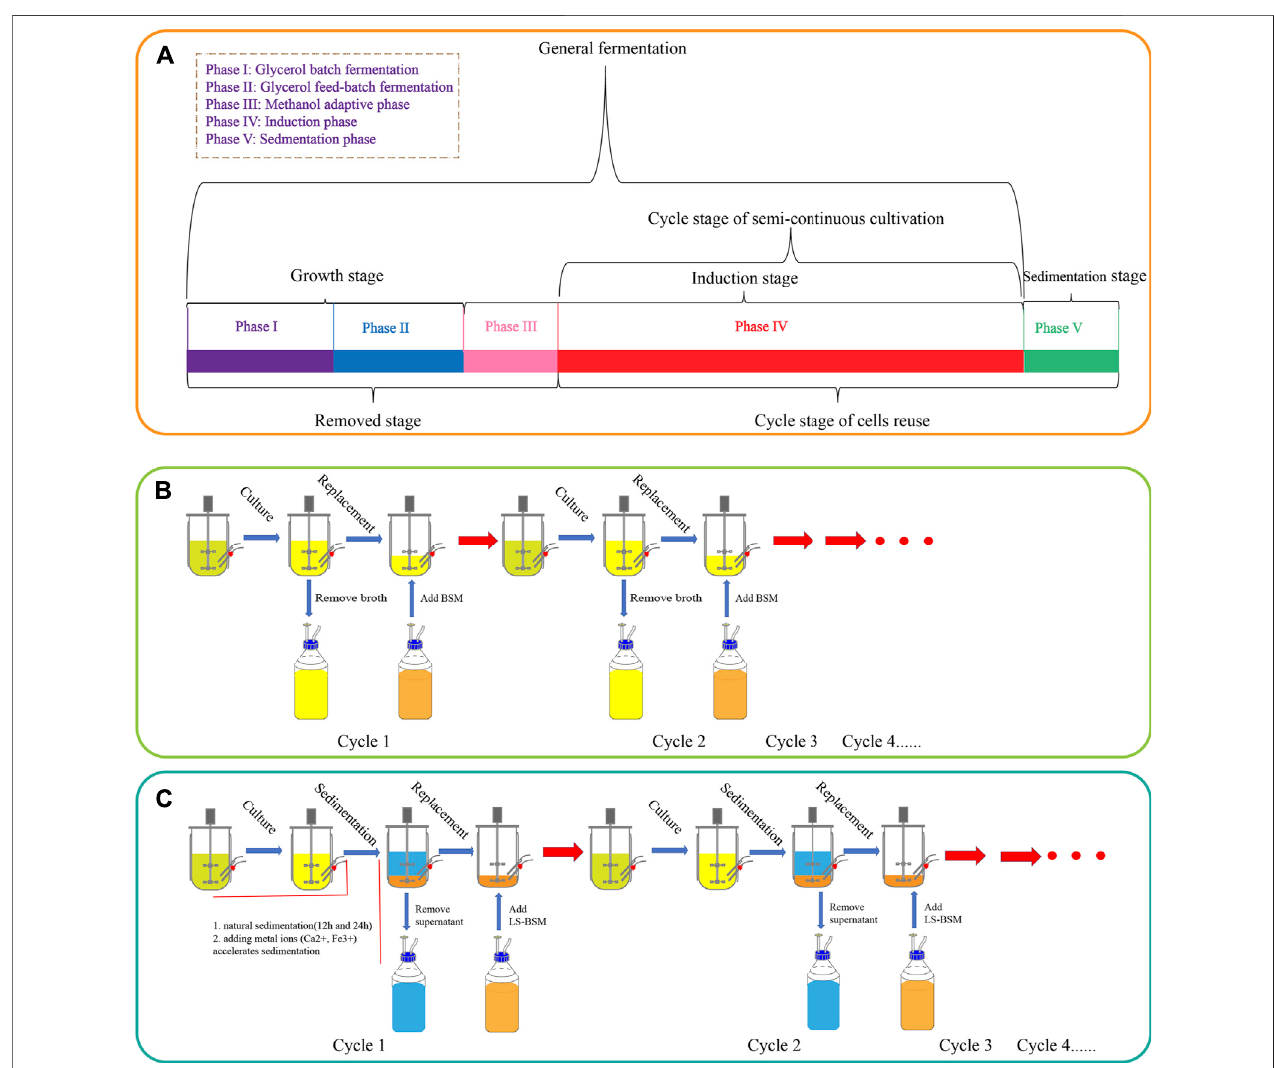
FIGURE 1 | The process fl ow of P . pastoris . (A) Division of P . pastoris culture stages. General batch-fed cultivation is divided into four stages. Semi-continuous cultivation repeats phase IV (induction stage). The new process that reuses cells adds asedimentation stage (phase V) to help cycle cells, and phase IV and phase V are cyclic. (B) A schematic diagram of semi-continuous cultivation. (C) A schematic diagram of the new process, including natural sedimentation and the addition of metal ions (Ca 2+ and Fe 3+ ) to accelerate